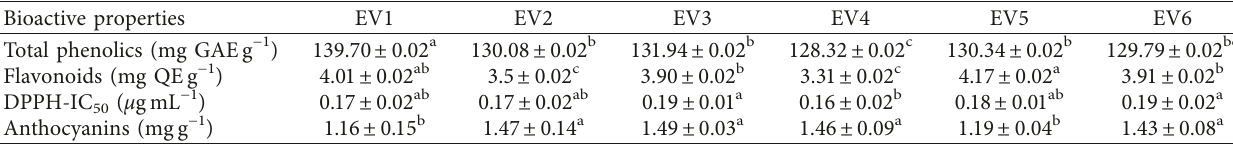
Table 6: Total phenolics, total flavanols, DPPH radical scavenging activity, and total anthocyanins in powdered compost extracts from Shiraz ( Vitis vinifera L.) and arrowroot ( Maranta arundinacea L.). Bioactive properties